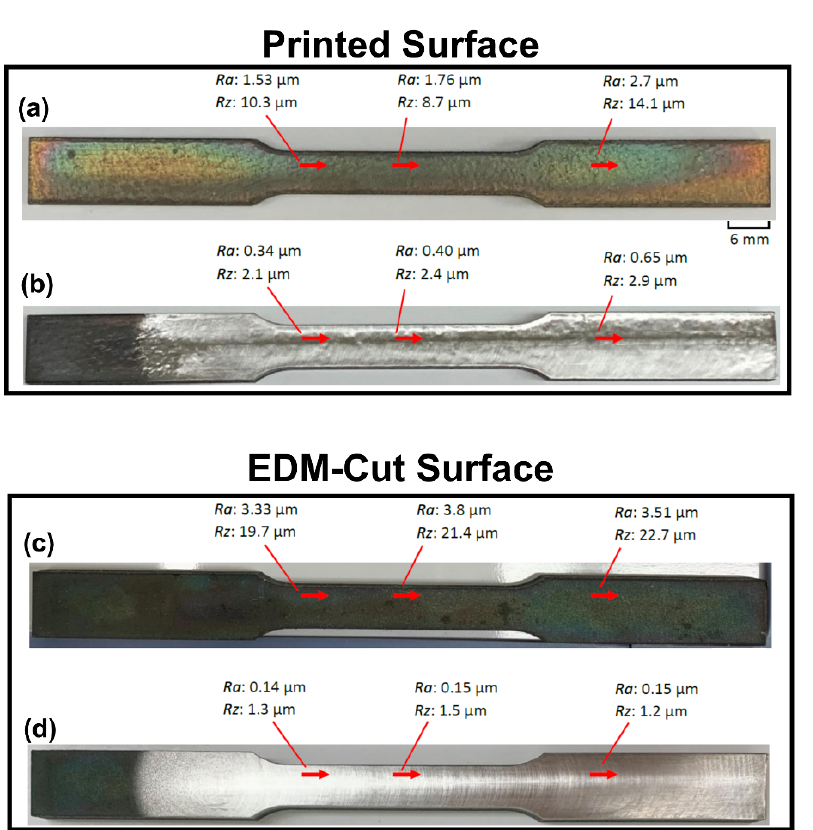
Figure 3. Images of the fully heat-treated samples before the MAF process (H + A) and after the MAF process (H + A + MAF): ( a ) printed surface before MAF and ( b ) after MAF; ( c ) EDM-cut surface before MAF and ( d ) after MAF.